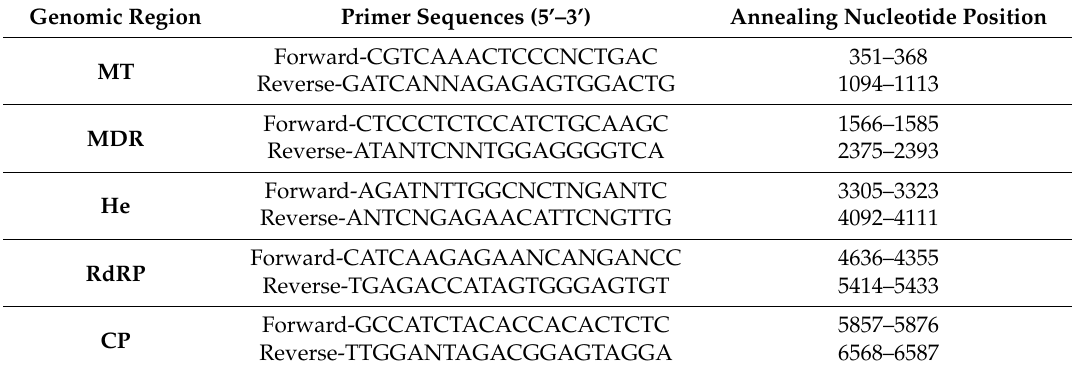
Table 2. Primer sequences designed based on five genomic regions of CSDaV